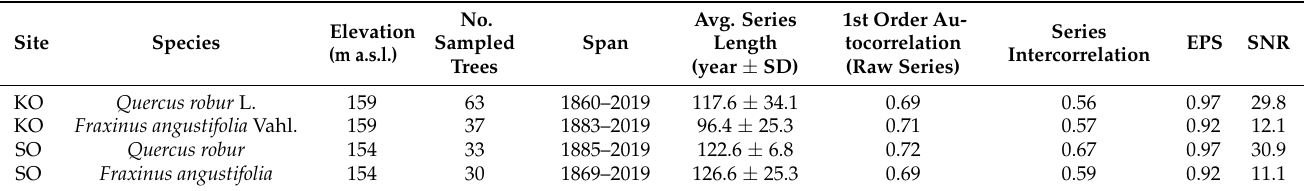
Table 1. Basic characteristics of the raw series and RWI30 site standard chronologies (EPS—Expressed population signal and SNR—Signal-to-noise